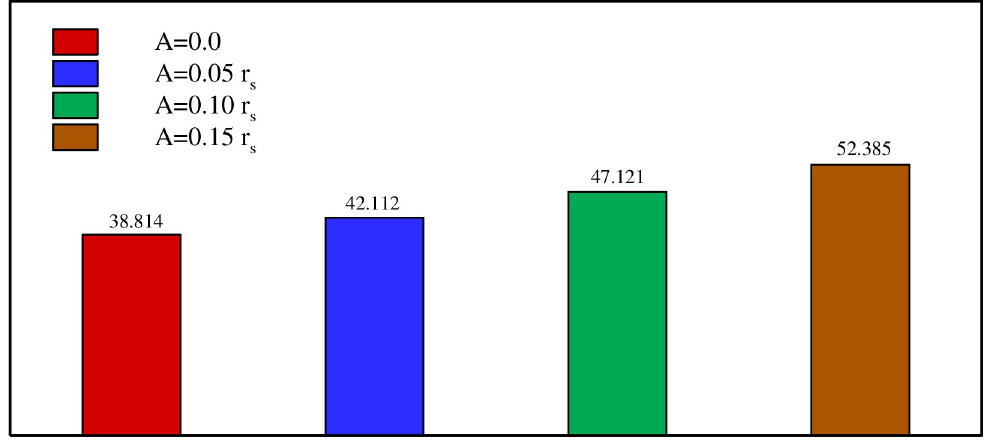
Fig 18. Comparison between the powers (W/m) on various the sinusoidal amplitude of the quasi-petal heat pipe when r d = 0.6 r s , Λ = 5, and η = π /4.